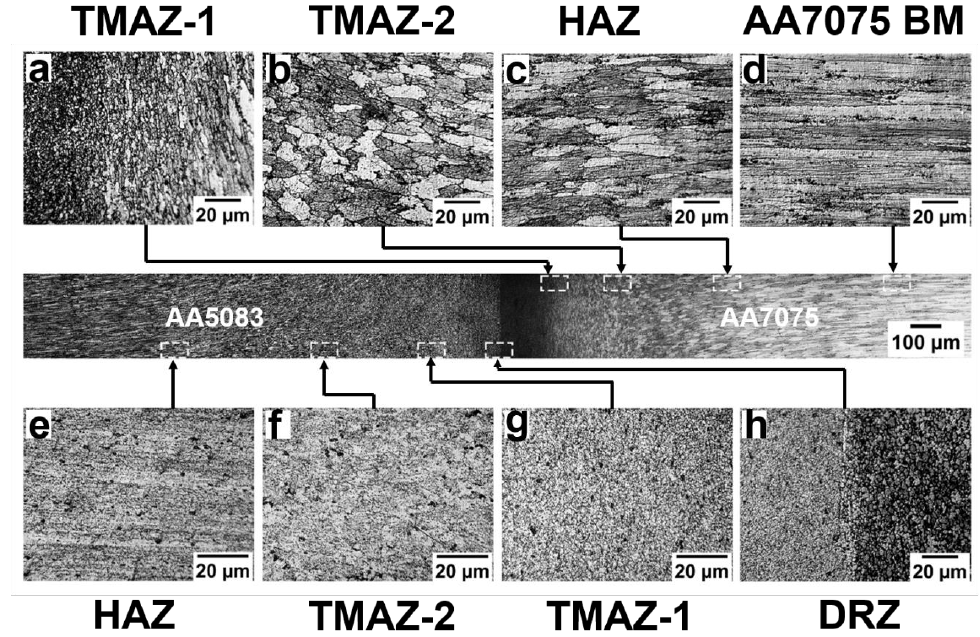
Figure 7. Microstructure across the weld interface of AA5083/AA7075-STA. AA7075 side: ( a ) TMAZ-1, ( b ) TMAZ-2, ( c ) HAZ, ( d ) base metal; AA5083 side: ( e ) HAZ, ( f ) TMAZ-2, ( g ) TMAZ-1, ( h ) DRZ.